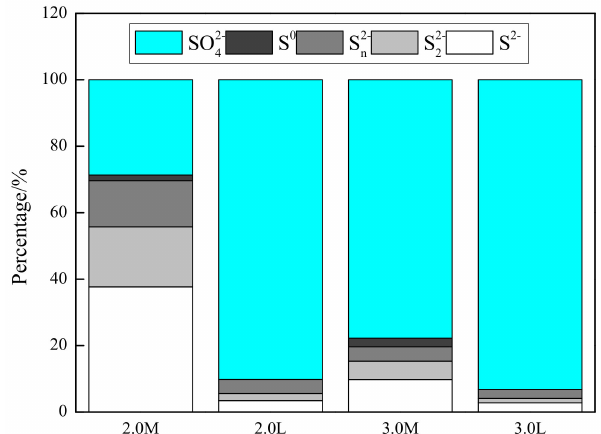
Figure 16. Contents of di ff erent sulfur species in the sulfur layer of pentlandite (2.0 M: pH = 2.00, leached for 8 days; 2.0 L: pH = 2.00, leached for 16 days; 3.0 M: pH = 3.00, leached for 8 days; 3.0 L: pH = 3.00, leached for 16 days).